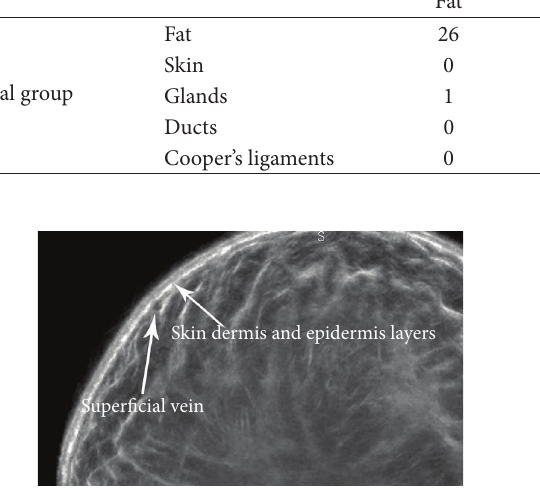
Figure 3: Magnified view of the reflection image at the skin surface showing the epidermal and dermal skin layers and a superficial vein in cross section.